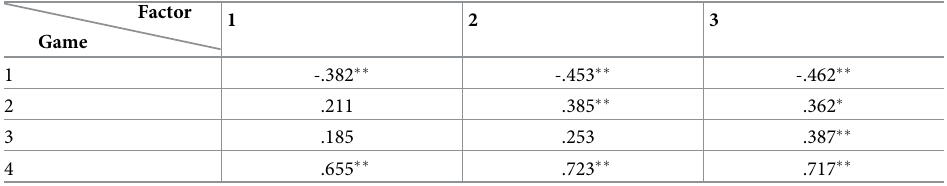
Table 1. Correlations of the language-related factors when the contexts were presented in the foreign